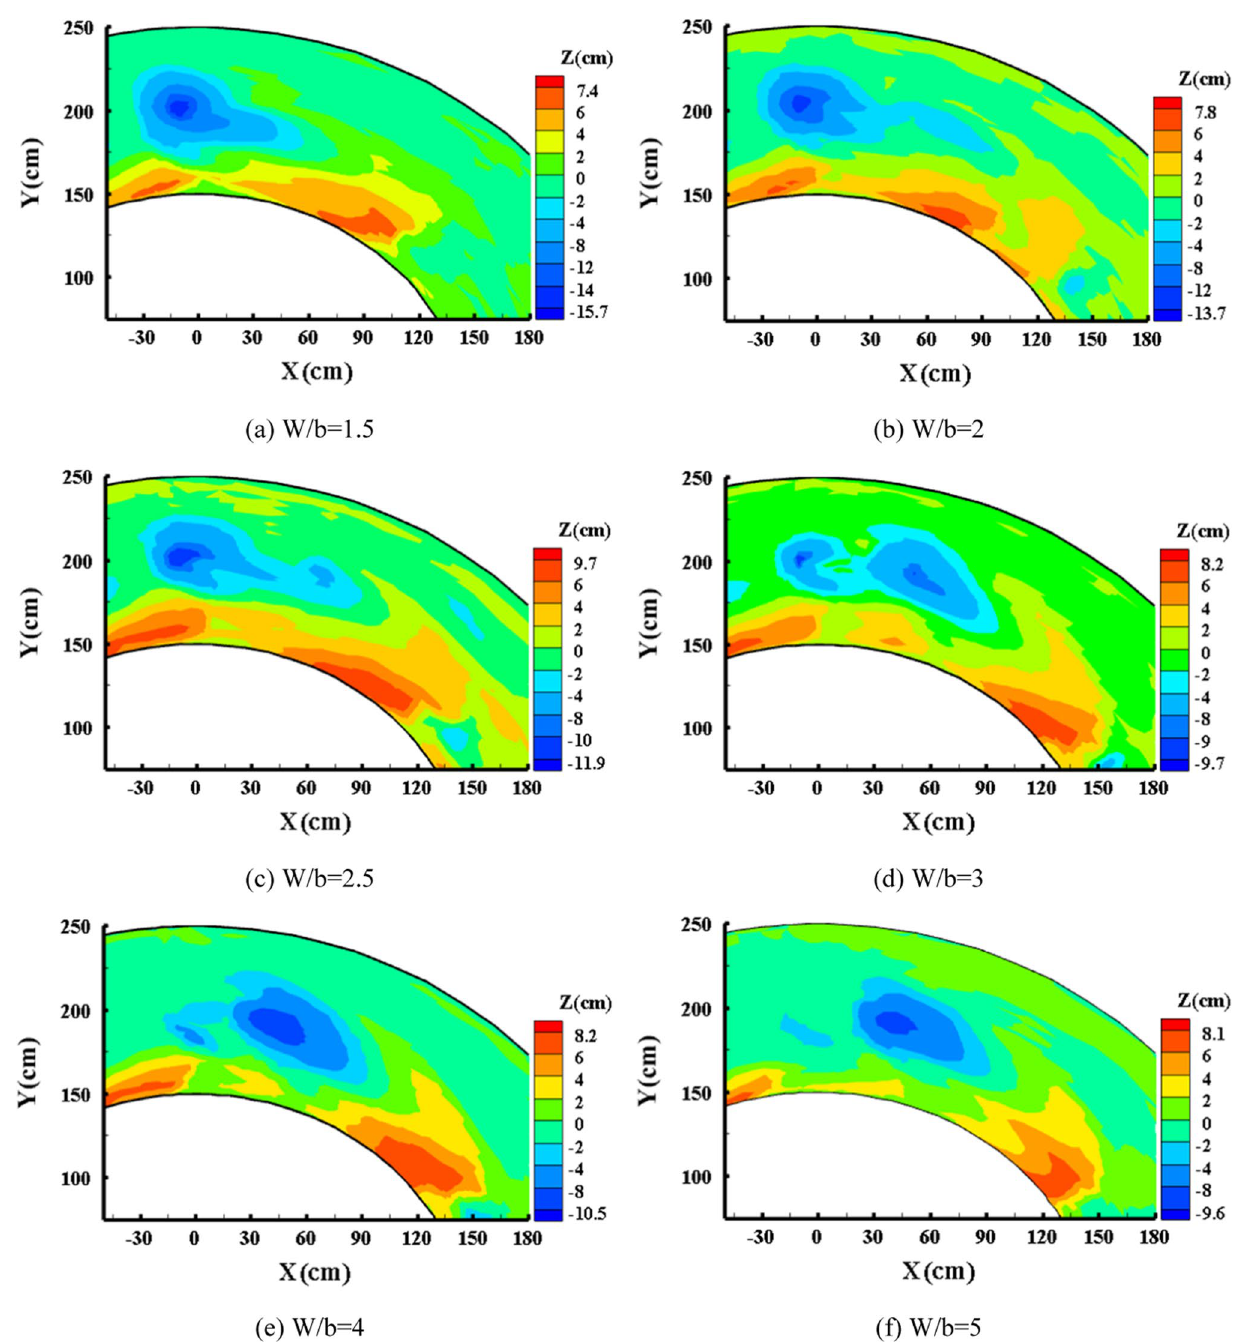
Fig. 7 The effects of increasing the width of collar on the changes of bed topography surrounding the pier of L =